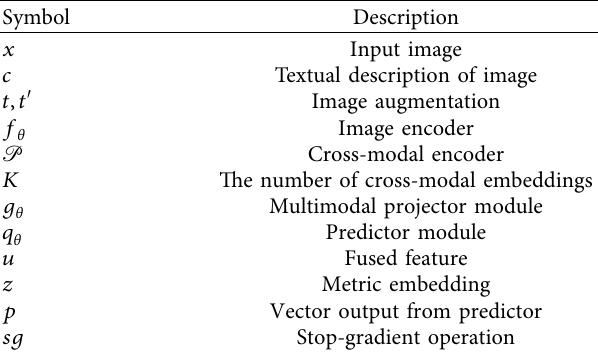
Table 1: Notation list of the proposed